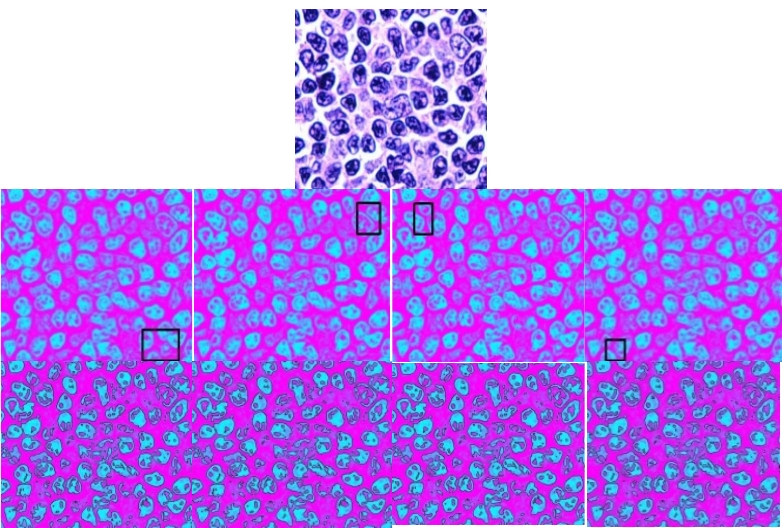
Figure 13. Follicular imagery, independent from contour initialization.